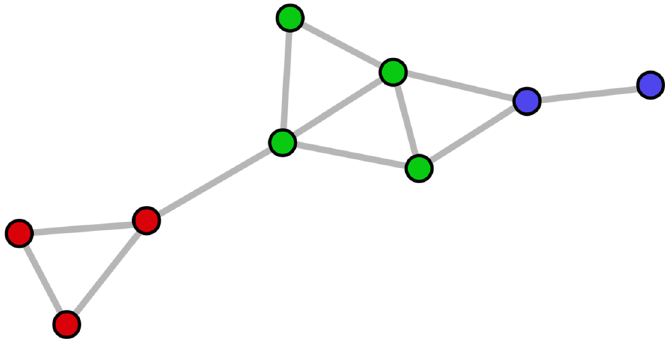
Fig 3. A sample network for which modularity (cid:4) 0.34, conductance (cid:4) 0.55, and coverage = 0.75. The color of each node defines its cluster.